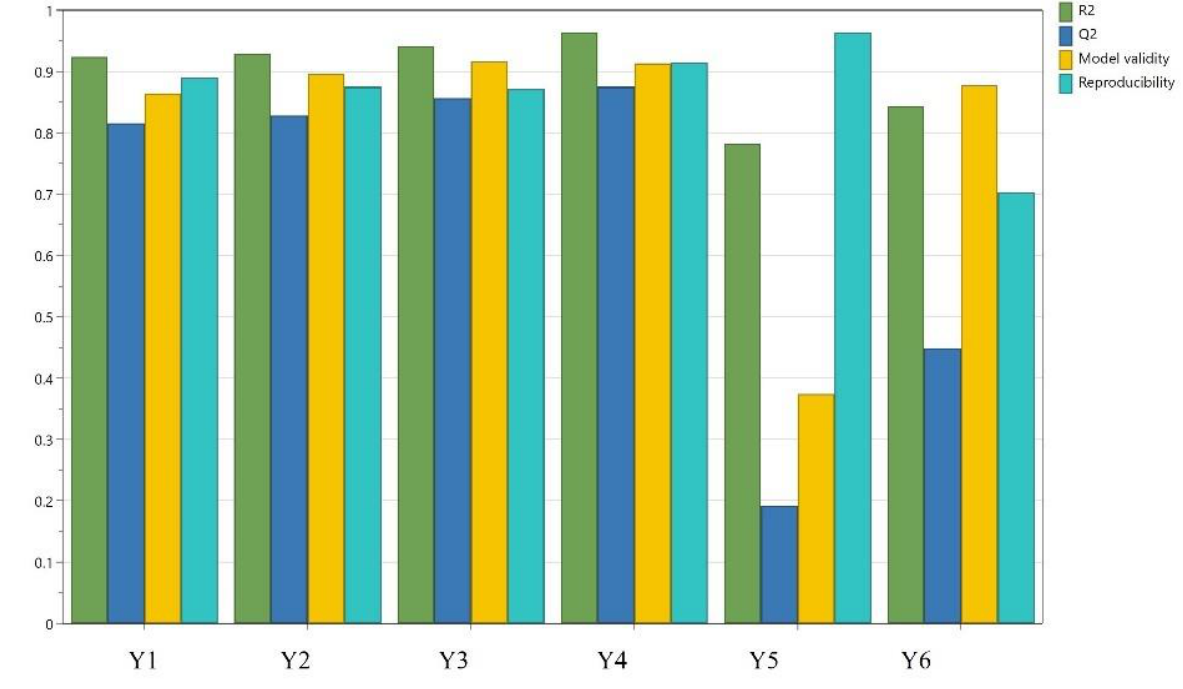
Figure 4. Summary of fit Y1, firmness; Y2, consistency; Y3, adhesiveness; Y4, stringiness; Y5, spreadability; Y6, viscosity.